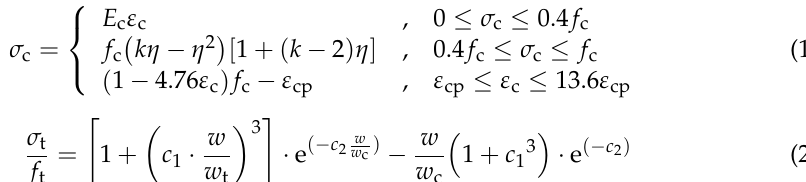
Figure 14. Constitutive relation curve of concrete. ( a ) Compressive stress–strain; ( b ) Tensile stress- crack width.